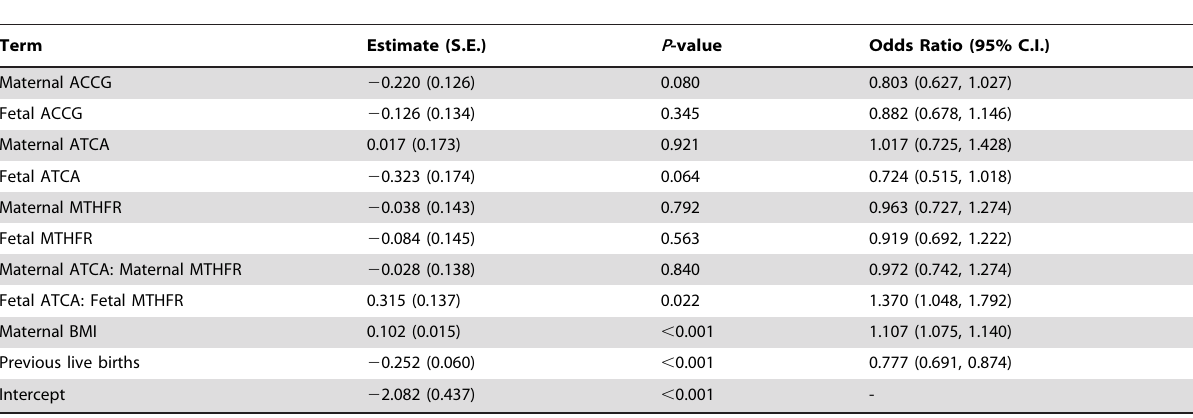
Table 6. A significant interaction ( P = 0.022) between the fetal Table 6. Logistic regression model of COMT-MTHFR interaction risks for preeclampsia.